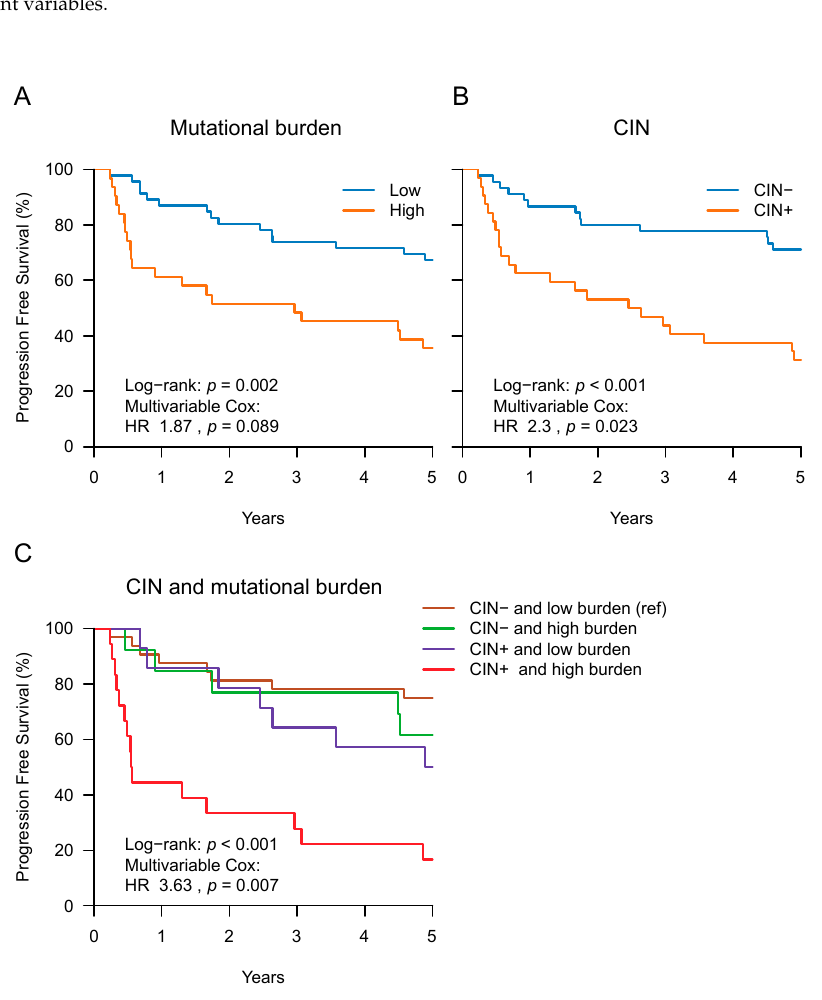
Figure 3. Progression Free Survival (PFS) according to mutational burden and chromosomal instability. Kaplan–Meier curves of PFS after patient classification by the following genomic factors in their tumors: ( A ) High or low mutational burden, ( B ) presence (CIN+) or absence (CIN-) of chromosomal instability markers (CIN) and ( C ) mutational burden and CIN. In-figure legends state hazard ratios (HR) and p -values from multivariable Cox models that included the tested genomic factor, HPV status, and tumor site. The HR shown in ( C ) refers to patients that have tumors with a high mutational